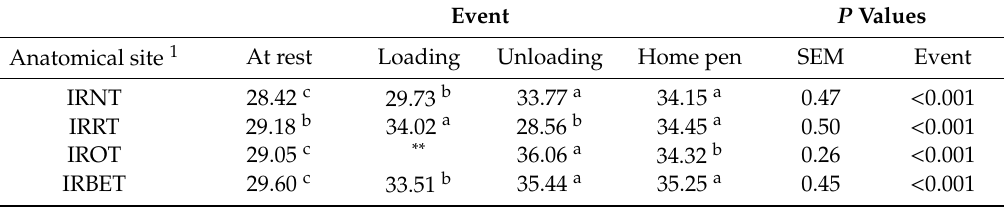
Table 3. Least square means of infrared body surface temperature by anatomical site and event.